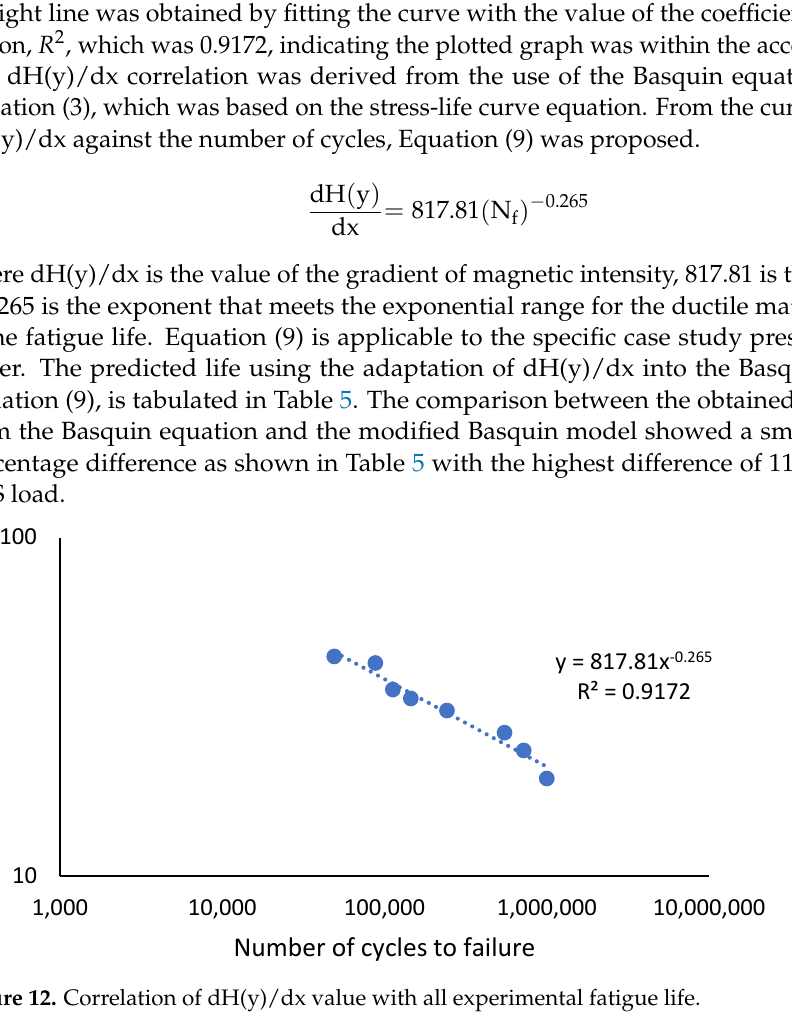
Table 5. Fatigue lives of API steel grade X65.